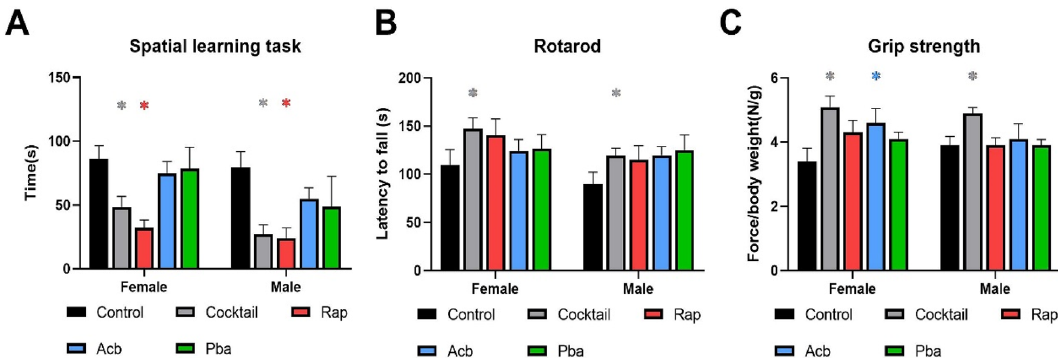
Figure 2. Performance tests were conducted in C57BL/6 mice at 23 months of age, three months after being started on chow containing the drug cocktail or placebo. (A) Values for the box maze were standardized times in seconds to find the escape hole in trial 3. (B) Values for the rotarod were standardized times in seconds staying on the rotating rod. (C) Values for grip strength were standardized force in newtons per body weight measuring the ability to maintain forepaw grip from a parallel meter bar. N = 12–14. *P < 0.05; 2-way ANOVA with Tukey’s post-hoc comparison and two-tailed, unpaired Student’s t-test.